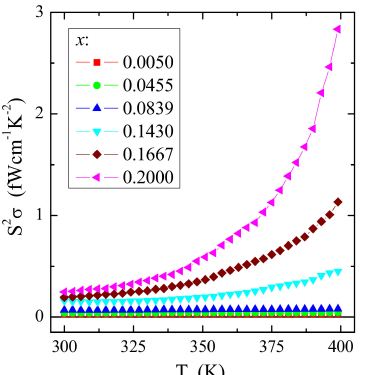
Figure 11. Power factor S 2 σ vs. temperature T of CCGMWO solid solution.